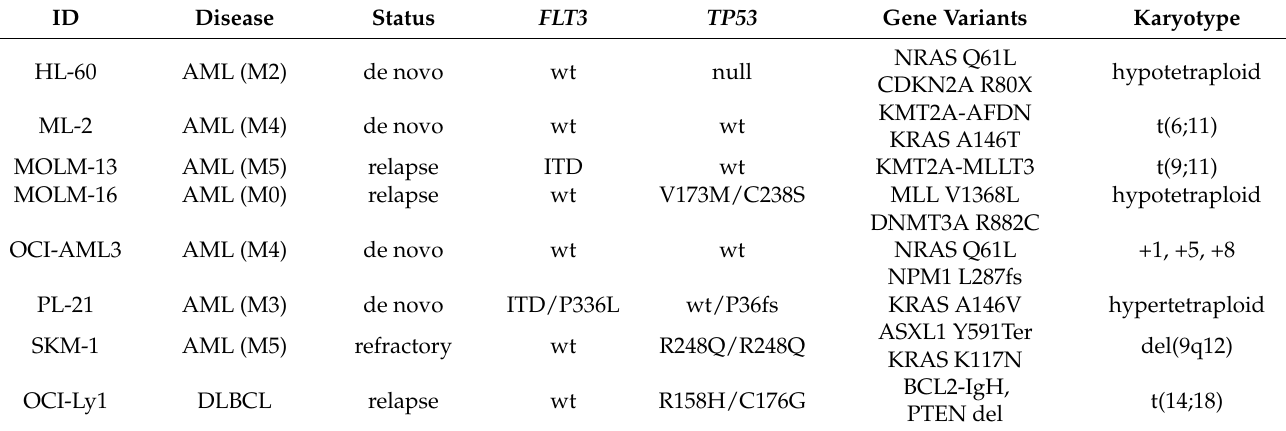
Table 1. Characteristics of leukemia and lymphoma cell lines.